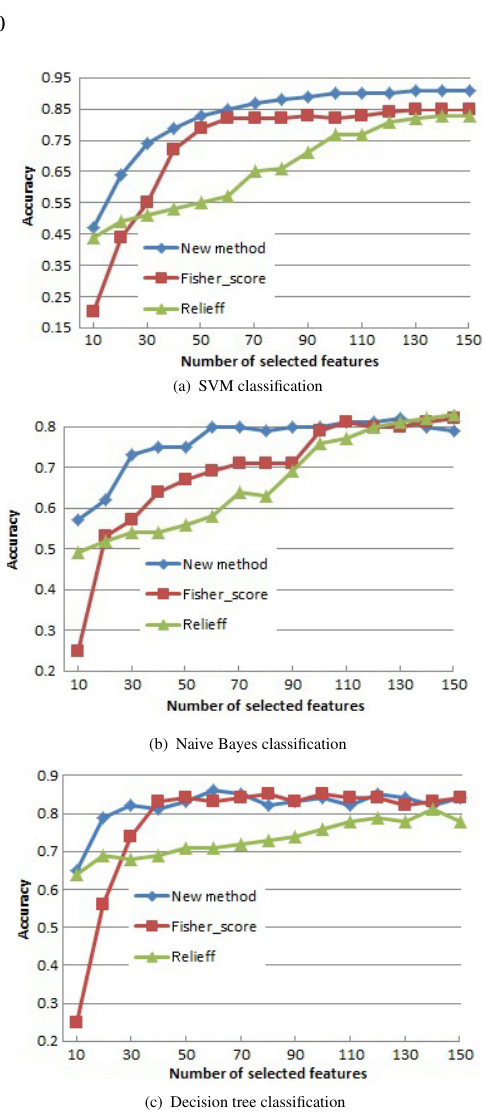
Fig. 4 Performance comparison of new FS with supervised FS on COIL20 image dataset.